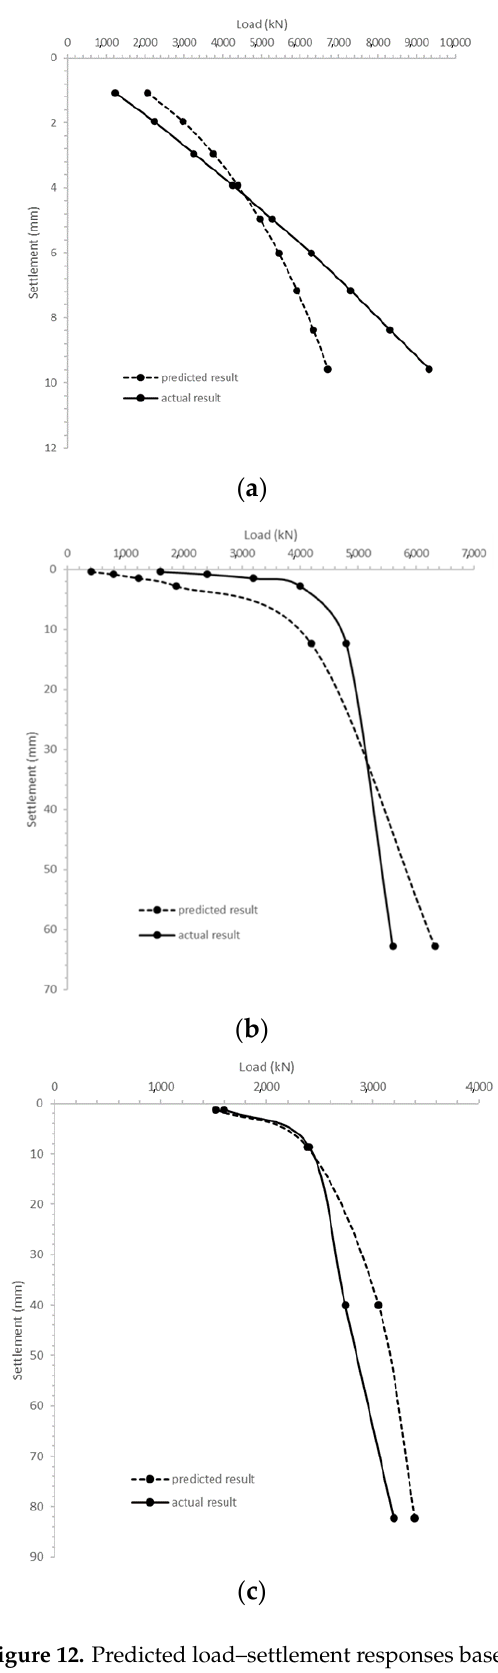
Figure 12. Predicted load–settlement responses based on modified closed-form analytical solutions for ( a ) upper part, ( b ) middle part and ( c ) lower